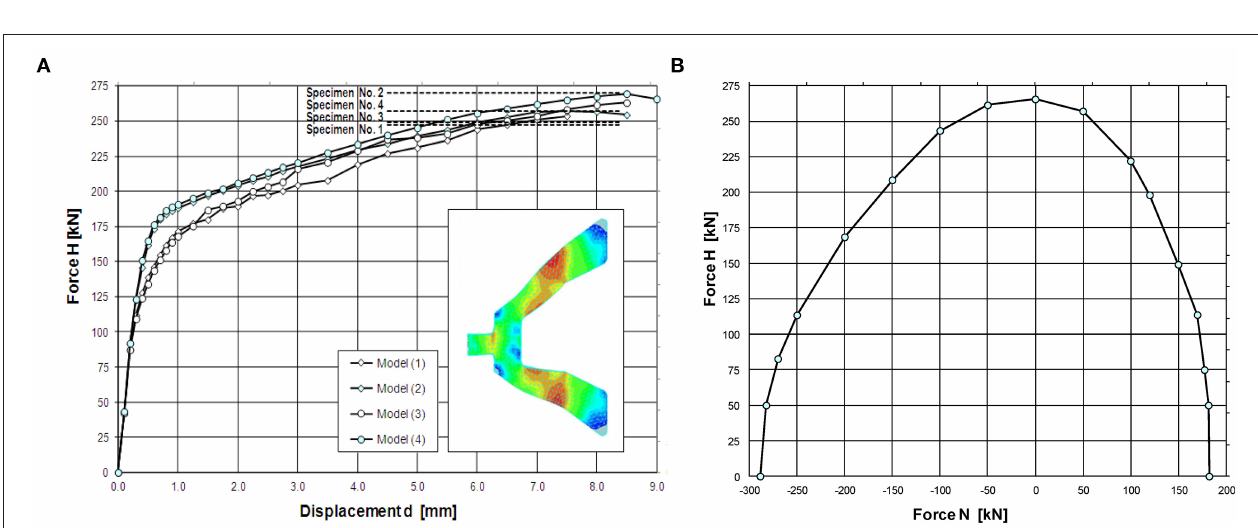
FIGURE 13 | Cladding shear key connection considered: (A) numerical shear pushover curves vs. experimental strength and (B) shear-axial interaction